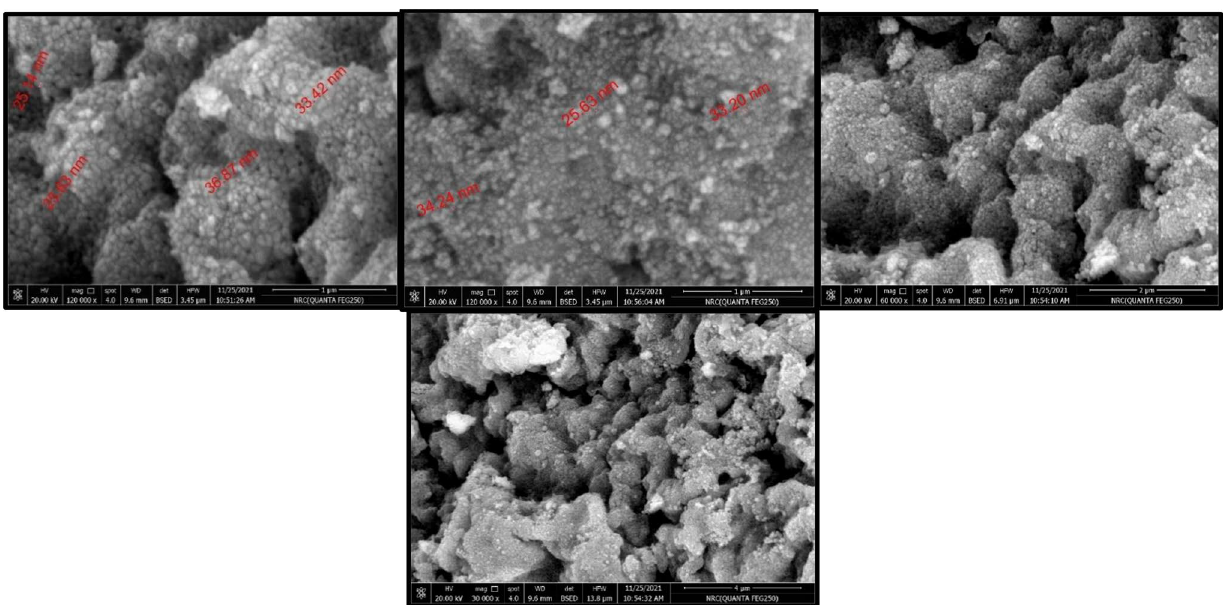
Figure 8. Scanning electron microscopy (SEM) images of CoAl 2 O 4 catalysts.